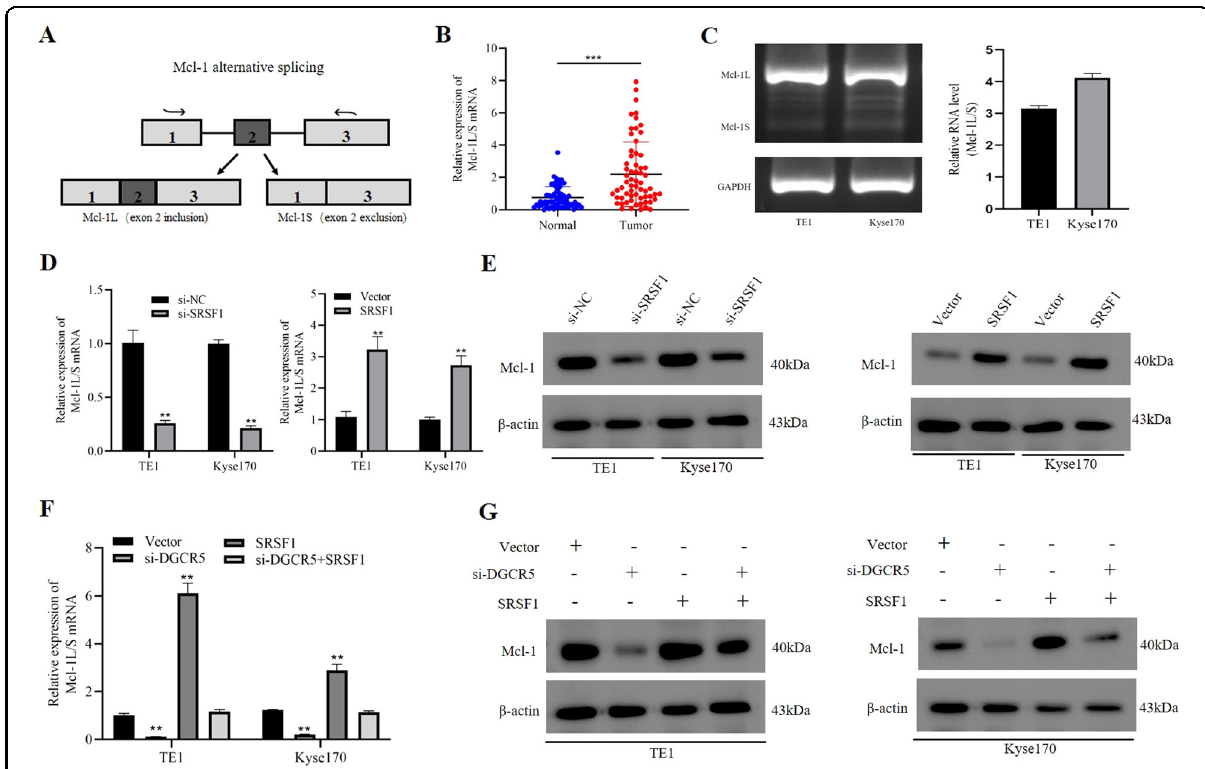
Fig. 5 DGCR5 regulates Mcl-1 expression through interacting with SRSF1. A SRSF1 regulated the alternative splicing of Mcl-1 pre-mRNA. B qRT- PCR was showed the Mcl-1L-to-Mcl-1S ratio in ESCC tissues. C Mcl-1L mRNA was obviously increased in TE1 and Kyse170 cells. D The Mcl-1L-to-Mcl- 1S ratio was detected when SRSF1 knockdown or overexpressed by qRT-PCR. E Mcl-1 protein level in ESCC cells was investigated when overexpression or knockdown SRSF1 by western blot. F , G Knockdown of DGCR5 inhibited the expression of Mcl-1 while SRSF1 overexpression promoted it at the mRNA and protein level, but knockdown DGCR5 and SRSF1 overexpression could reverse it. * P < 0.05 and ** P <